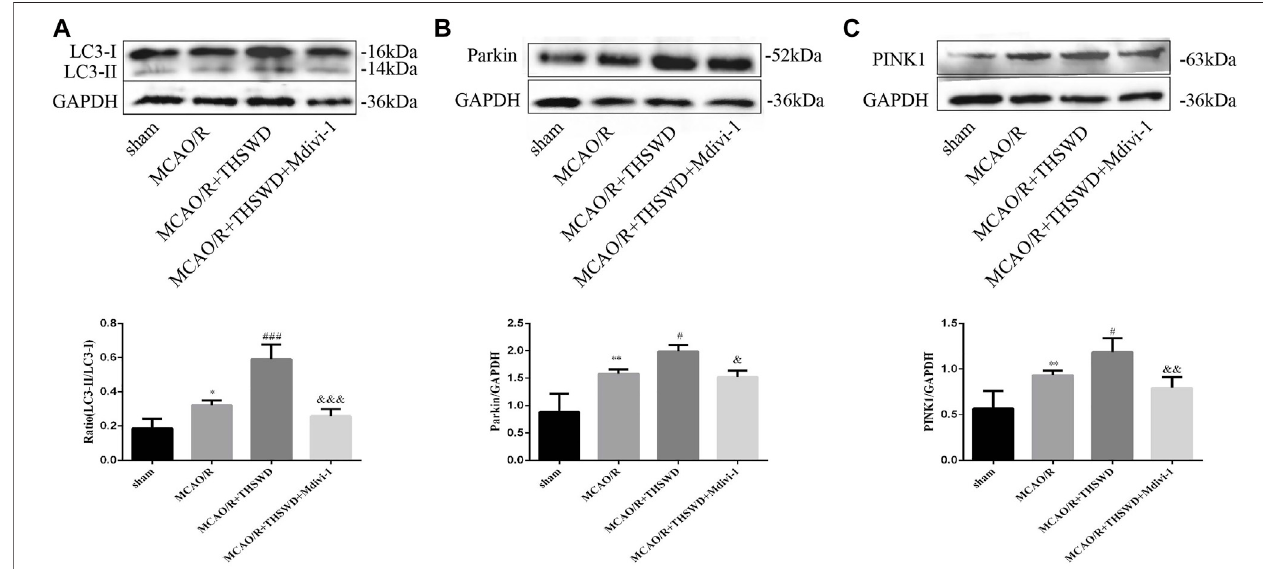
FIGURE 4 | Effects of THSWD treatment on mitophagy proteins. (A – C) The Western blot relative band density of LC3, Parkin, and PINK1; n = 6 per group. Each experiment was repeated 3 times. * p < 0.05, ** p < 0.01 versus sham group, # p < 0.05, ### p < 0.001 versus MCAO/R group, & p < 0.05, && p < 0.01, &&& p < 0.001 versus MCAO/R + THWSD